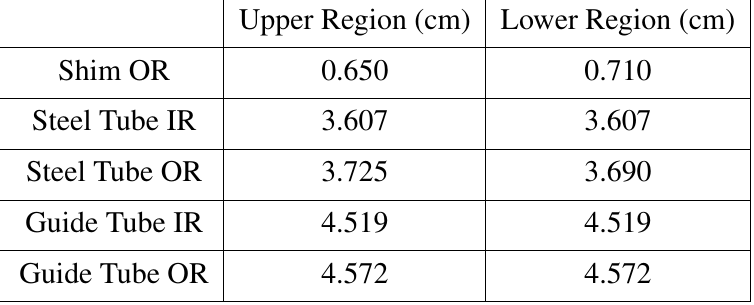
Table 1: Adjuster Rod Regional Dimensions